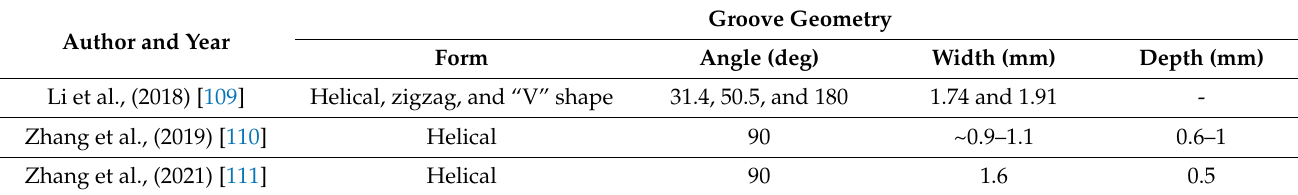
Table 11. Geometries and dimensions of the grooves produced by AWJ.